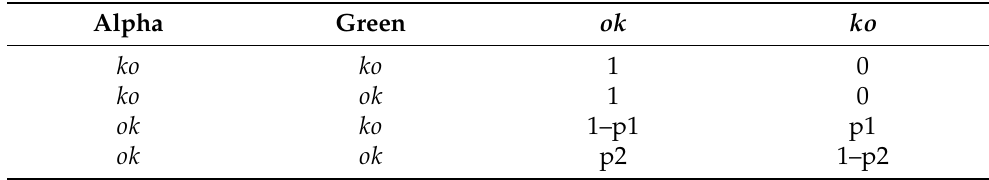
Table 1. The CPT of C1A